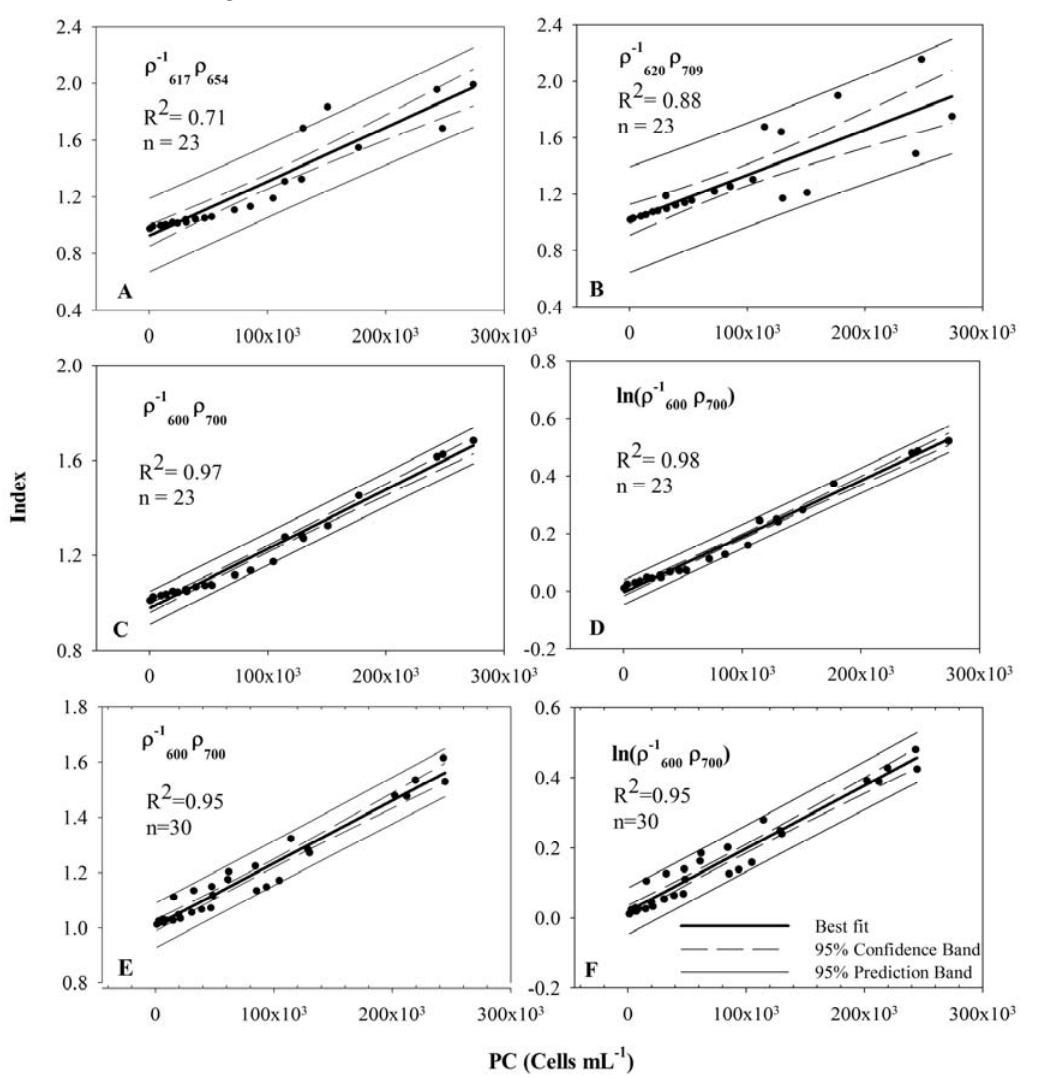
Figure 5. Calibration scatter plots (PC concentration versus Index) for different band ratio models: (A, B, C, D) data from EXP I, II and III ( Synechocystis ) and (E, F) data from EXP I–IV ( Synechocystis and Anabaena ). Coefficients of determinations (R 2 ) for each model are also reported in corresponding figures. Outer pairs of lines (solid) represent 95% prediction band, inner pairs of lines (dash) represent 95% confidence band and the central solid lines are linear regression